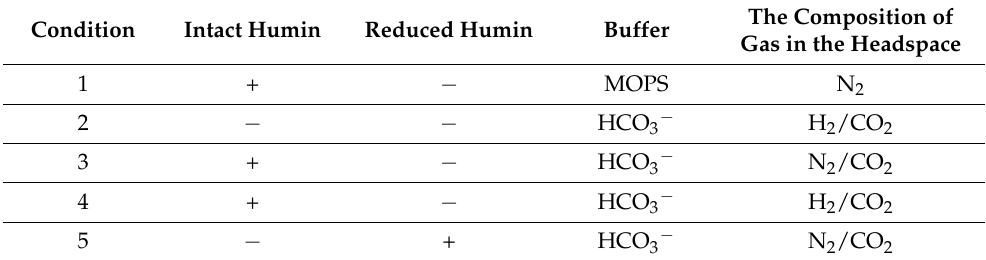
Table 1. Experimental